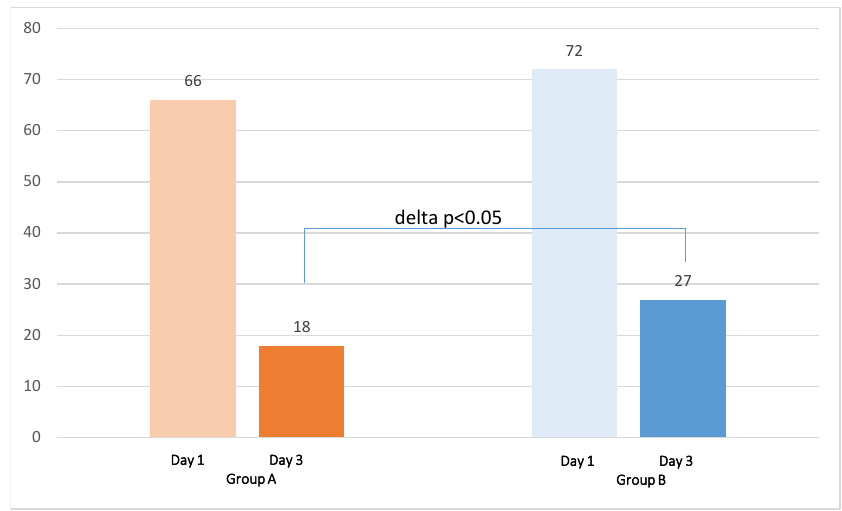
Figure 3. Comparison of mean C-reactive protein (CRP) levels between Group A (supplemented with the probiotic mix) and Group B (control group; standard treatment without probiotics) at enrolment (Day 1) and Day 3.